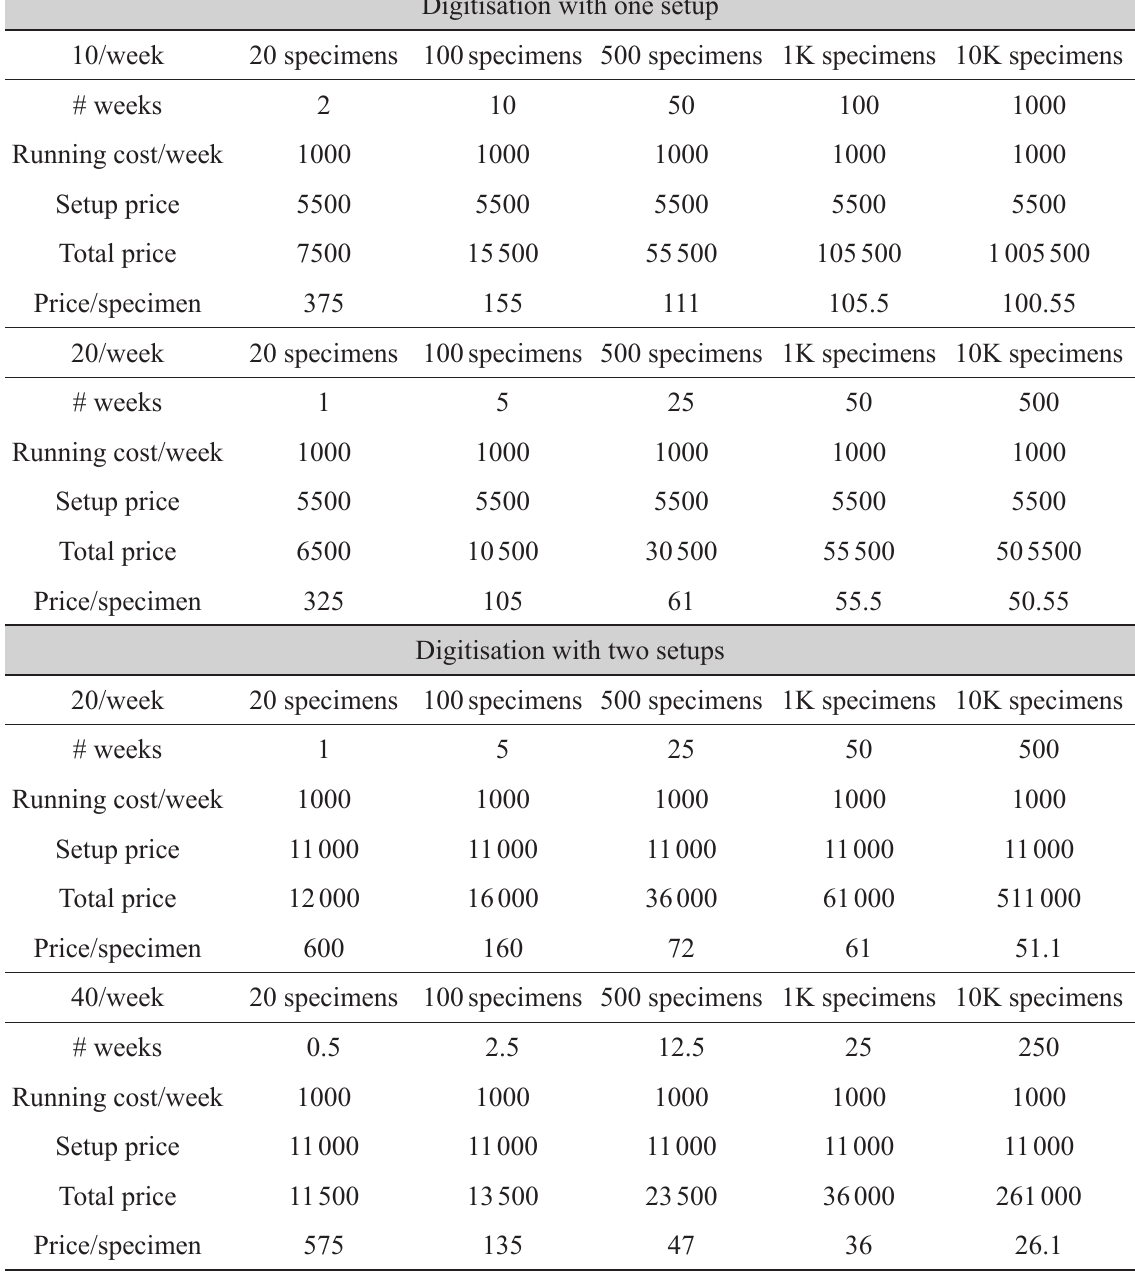
Table 3.4. Overview of the digitisation costs (euro) for one or two running setups, with respectively 10/20, or 20/40 digitised specimens per week, given per collection size (20, 100, 500, 1000 or 10 000